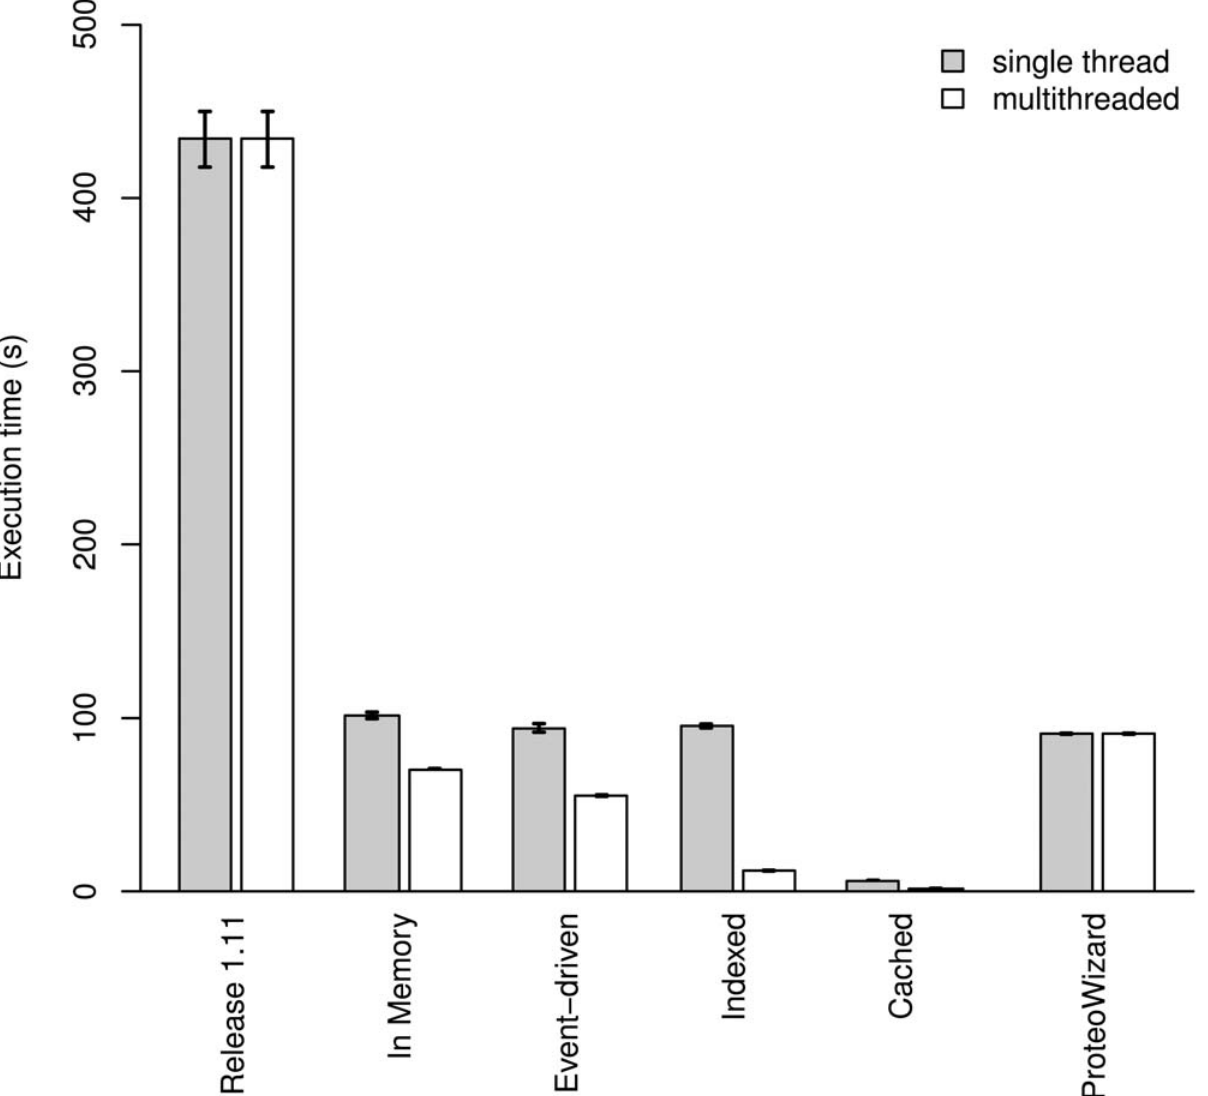
Fig 1. Processing time (s) for the different algorithms. The time to process a single 6.9 GB file (containing 456 million peaks) is depicted for the different algorithms with and without multithreading enabled. The processing time using the ProteoWizard library is added for comparison. While our in-memory and our event-driven data access routines are substantially faster than data access using the OpenMS 1.11 code, the novel “ cached ” data format is an order of magnitude faster than all other data access methods. Note that some implementations, such as OpenMS 1.11 or ProteoWizard, are not capable of utilizing multiple threads. Comparisons were performed using the TICCalculator and files described in the text using a single thread or 16 threads for the multithreaded bar.